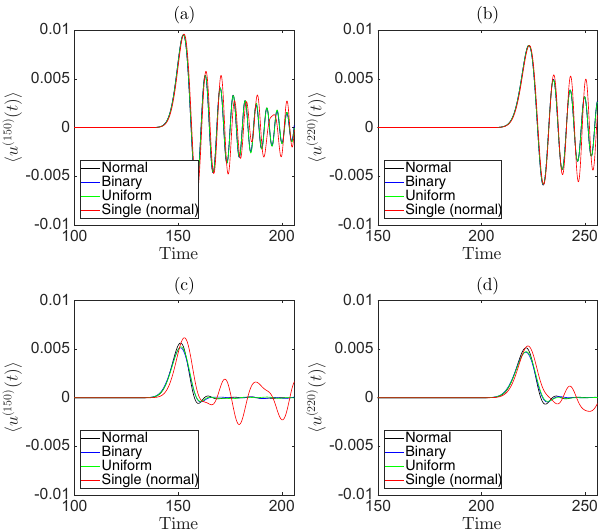
Figure 5. Ensemble-averaged displacements (500 times) of the 150th (a, c) and 220th (b, d) particle with respect to time. Panels (a, b) have disorder parameter ξ = 0 . 1, (c, d) have disorder parameter ξ = 0 . 5. The red line is the space–time response from a single re- alization of a chain with normally distributed masses. For all single realizations, normal distributions are used with e M 1 = 0 . 9971 and e M 2 = 1 . 1274 for ξ = 0 . 1 and e M 1 = 0 . 9958 and e M 2 = 1 . 2636 for ξ = 0 . 5.